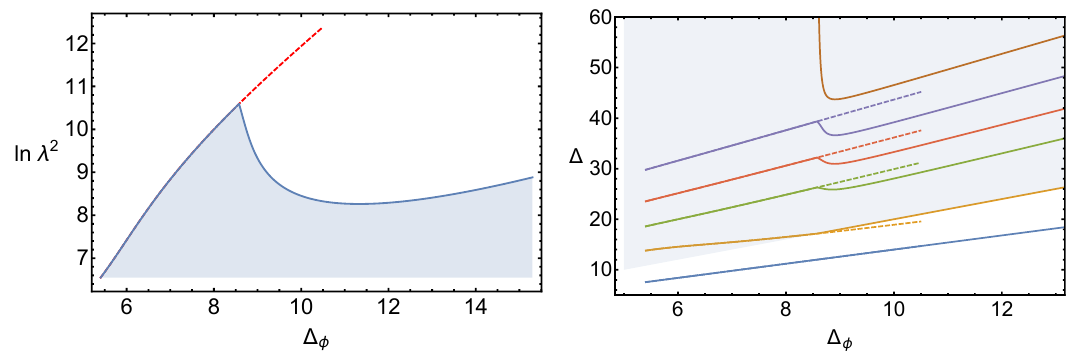
Figure 12 . A human-made kink. On the left, bound on the OPE coe(cid:14)cient of an operator of dimension (cid:1) = 1 : 4 (cid:1) (cid:30) , with all other operators above (cid:1) = 2 (cid:1) (cid:30) . On the right the corresponding gap spectra. Only to the right of the kink is there an operator saturating the gap. To its left, an extra operator at (cid:1) = 1 makes a (cid:12)nite contribution to the solution. The dashed lines are the continuation of the extremal solution ignoring (cid:1) . All computations done with N = 10 gap